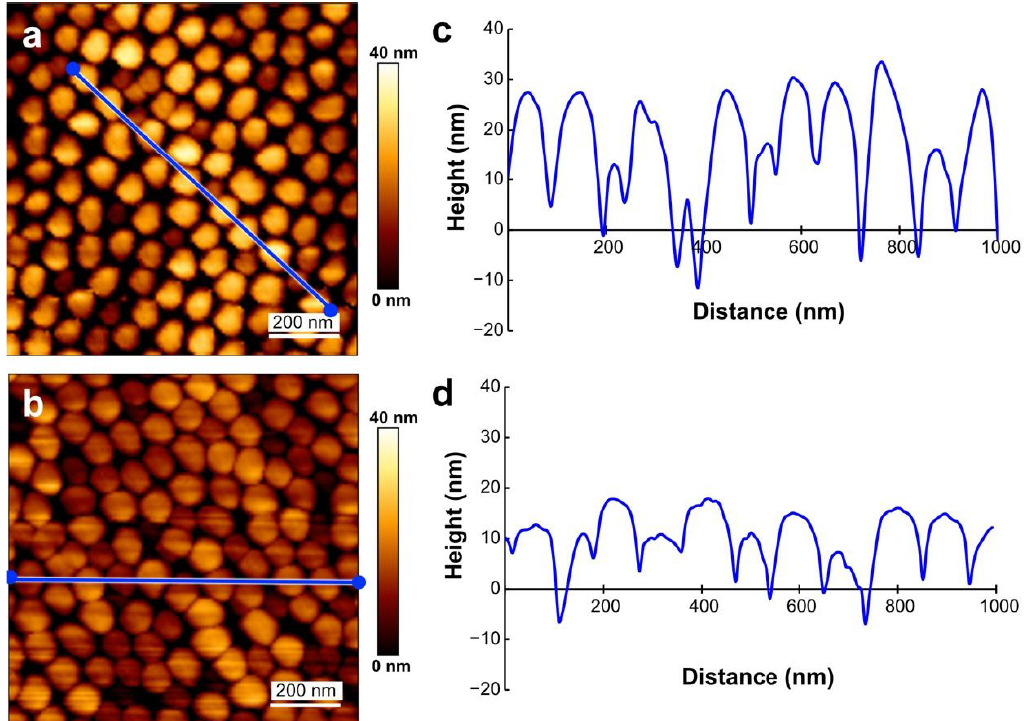
Figure 2. AFM images of the MOSMITE™ surface under water ( a , c ) and in the air ( b , d ). The profiles ( c , d ) are the cross sections along the blue lines in ( a ) and ( b ), respectively.